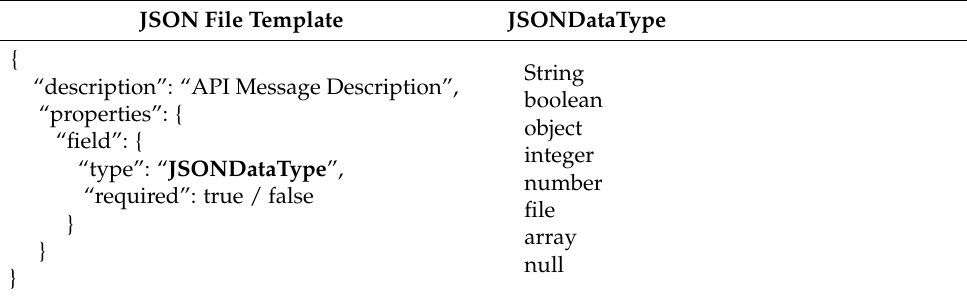
Table 4. Template file for API message